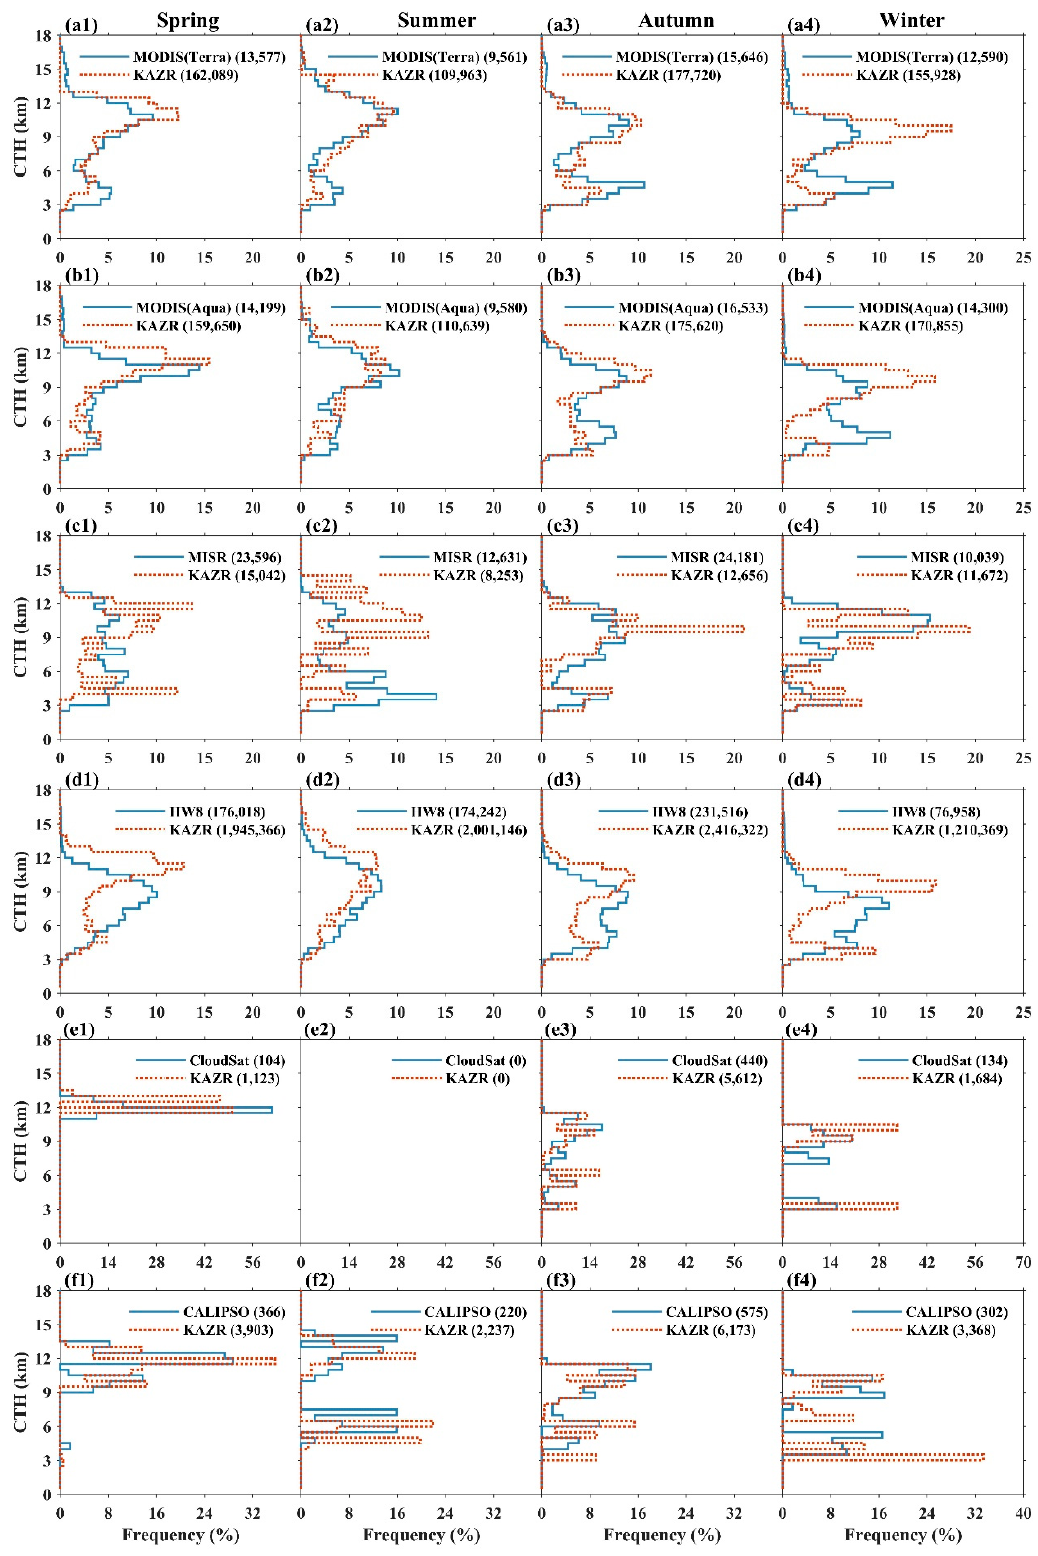
Figure 4. Seasonal frequency histogram of CTH for non-overlapping clouds for different satellite-KAZR pairs, MODIS (Terra, ( row a )), MODIS(Aqua, ( row b )), MISR ( row c ), HW8 ( row d ), CloudSat ( row e ), and CALIPSO ( row f ), during different seasons, spring (March/April/May, column 1), summer (June/July/August, column 2), autumn (September/October/November, column 3), and winter (December/January/February, column 4).